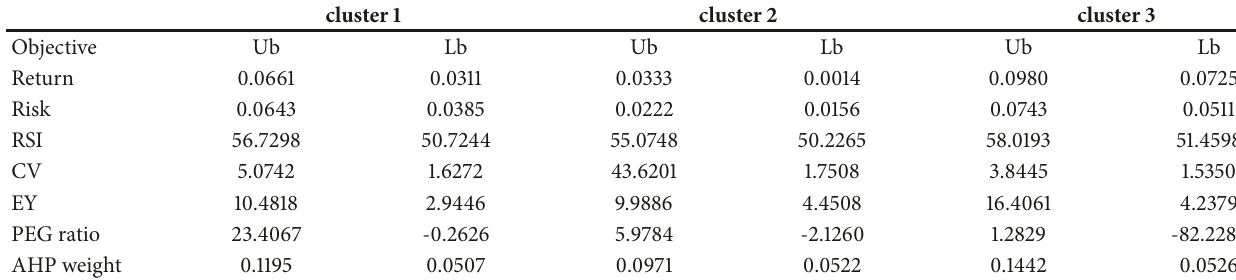
Table 7: Upper bound and lower bound.